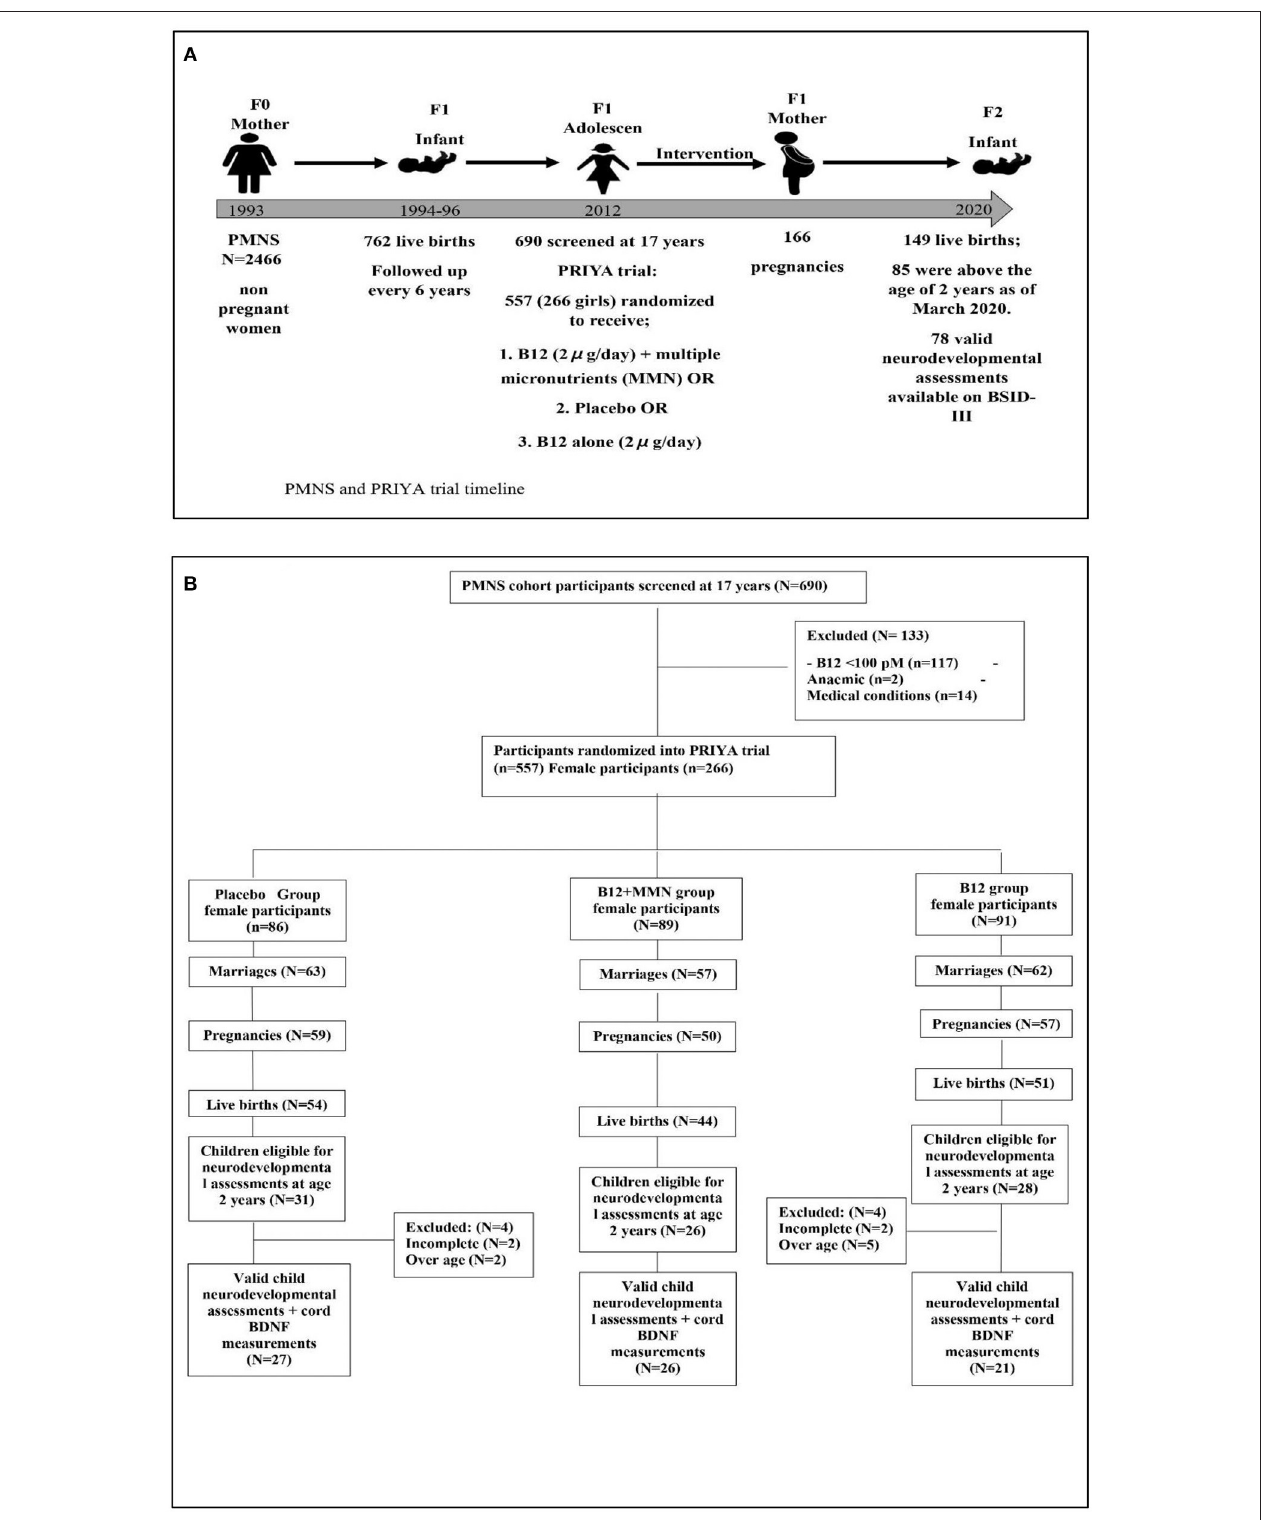
FIGURE 1 | Diagram depicting the study timeline (A) and recruitment of study participants (B) for neurodevelopmental follow up as of February 2020. Further collection of data discontinued due to COVID-19 pandemic.